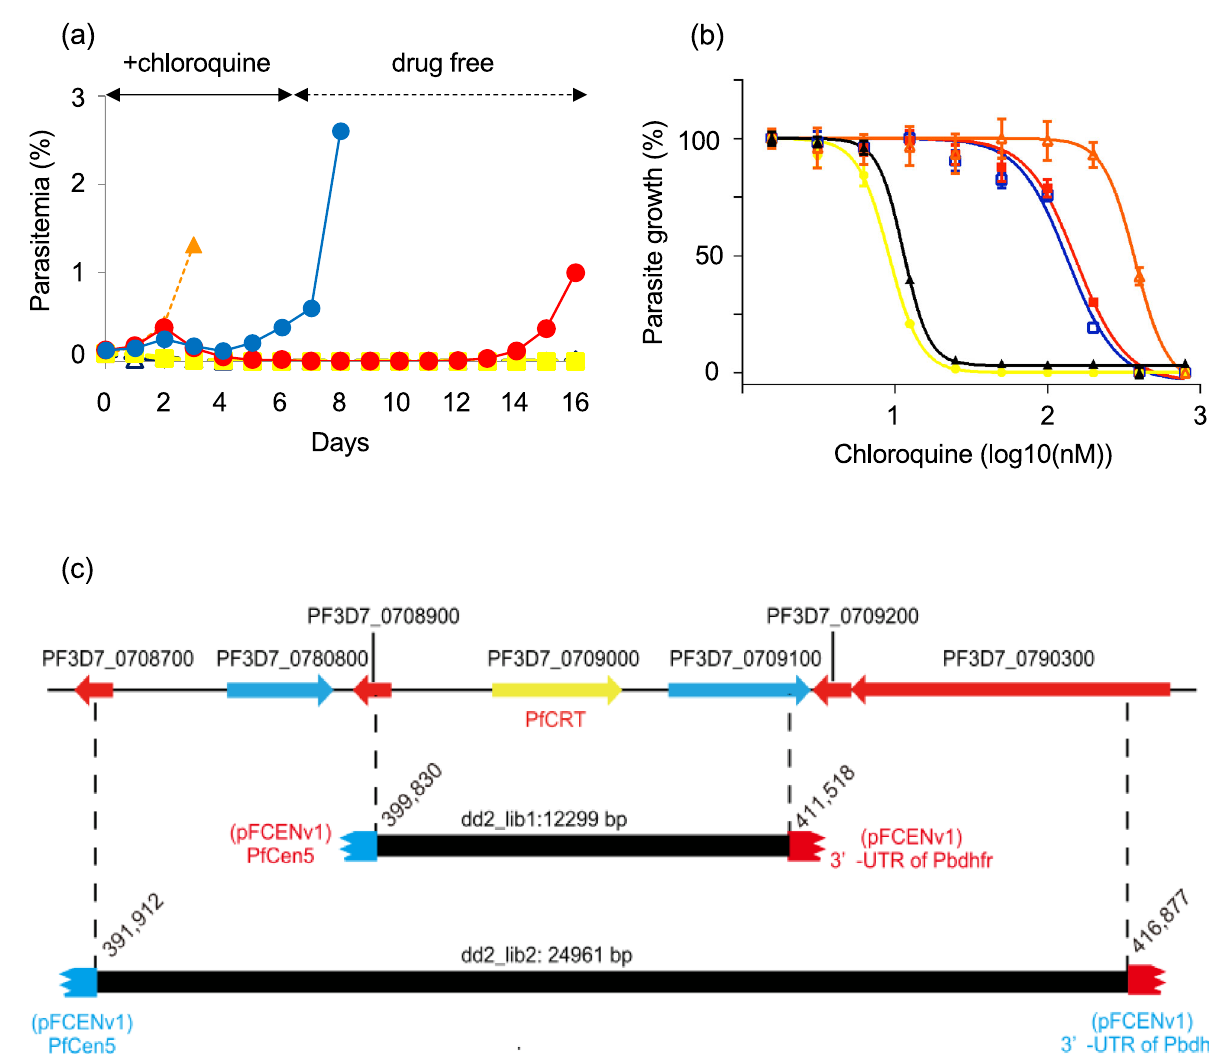
Fig. 2 | Functional screening of a chloroquine-resistance gene from the geno- mic libraries of strain Dd2. a Parasites [dd2-lib1 (red), 2 (blue), 3D7 (black), Dd2 (orange), and the negative control parasite (yellow)] were treated with 20-nM chloroquine for 6 days. The transgenic parasite, in which the pFCENv1 was intro- duced,wasusedasanegativecontrol. b TheIC 50 valuesofclonalparasitesselected from dd2-lib1 and 2 were determinedfrom The values for strains 3D7and Dd2and